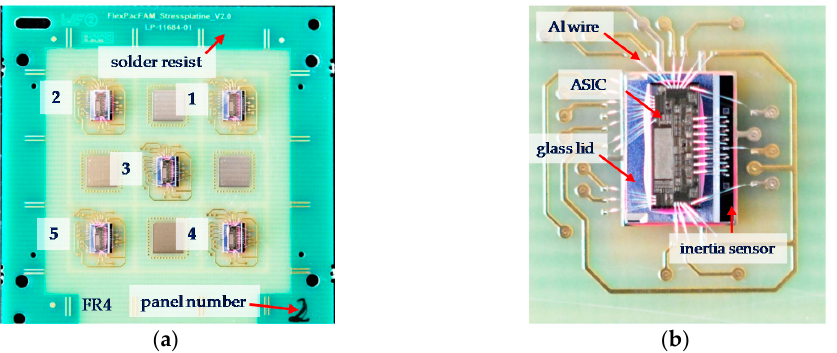
Figure 5. ( a ) Test panel with five mounted sensor stacks and ( b ) detailed view of the stack assembly of the inertia sensor and ASIC on PCB with aluminum (Al) bond wires as electric interconnect to die and PCB.